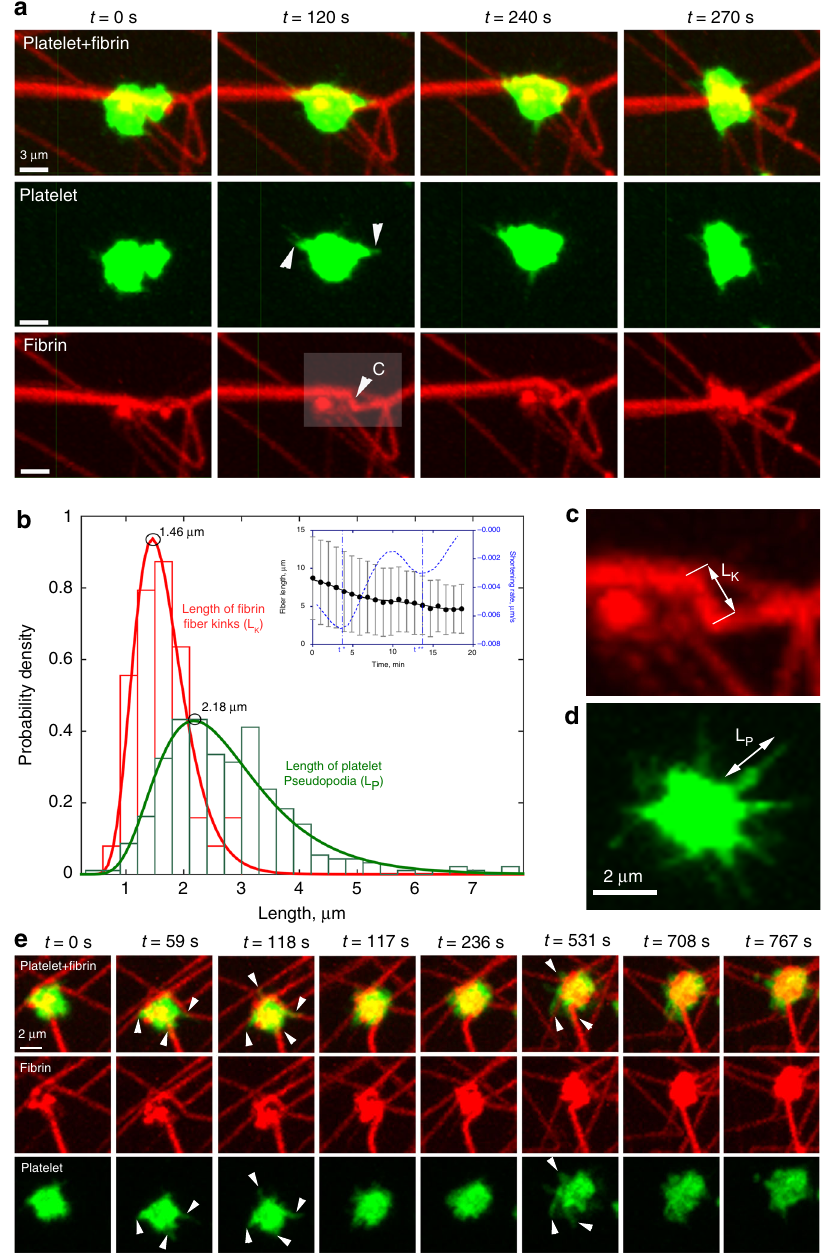
Fig. 1 Time-lapse images of contracting platelets that cause bending, kinking, and local accumulation of a single fi brin fi ber. a Top row : a platelet or a small platelet aggregate ( green ) attaches to a fi ber ( red ) and spreads fi lopodia along the fi ber axis that contract, inducing a fi ber kink and pulling the fi ber, compacting it into a dense fi brin knot or coil. For details see Supplementary Movie 1. a Middle row : platelet transformations, including attachment of fi lopodia to a fi ber, spreading and contraction (corresponding to a , top row ). a Bottom row : platelet-induced structural changes in a fi brin fi ber. The inset ( t = 120s) shows formation of a kink. Arrows indicate fi lopodia attached to a fi ber, including the kink. b Length distributions of the fi ber kinks, L K ( n = 42) and platelet fi lopodia, L P ( n = 300). The bars represent experimental numbers and the curves are log-normal fi ts. Inset : shortening of a fi brin fi ber ( black dots ) and the shortening rate ( blue dotted line ) caused by platelet contraction (mean ± SD, n = 30). t*, t** are the microscopic phase transition times separating different regimes of fi lopodia shortening. c A zoomed fi ber kink of a length L K . d Filopodia with lengths de fi ned as L P ; both parameters presented in b . e Serial images of a contracting platelet reveal reorganization and compaction of fi brin fi bers surrounding the cell. Top row : combined fi brin and platelet images; middle row : fi brin network only; bottom row : platelet only. Arrows indicate the platelet ’ s fi lopodia attaching to and pulling on fi brin fi bers. (see Supplementary Movie 3 for the full sequence at high magni fi cation and Supplementary Movie 4 for an individual platelet fi lopodium undergoing contraction) fi brin as compared to fi brin accumulated by single platelets. Since ( S SP = 9 µ m 2 ) dropped from 100% to 33 ± 9% ( n = 110). As the maximum size of a compacted fi brin bundle is determined by the formation of compacted fi brin is driven by platelet actomyosin size of an associated platelet aggregate, our fi ndings suggest that contractile machinery, a platelet aggregate dissipates more energy platelet aggregation enhances remodeling of fi brin matrix and on pulling and compacting fi brin than an individual platelet by results in formation of larger clumps of densi fi ed (or compacted) deforming a larger number of fi brin fi bers. Therefore, platelet NATURE COMMUNICATIONS | 8: 1274 | DOI: 10.1038/s41467-017-00885-x |